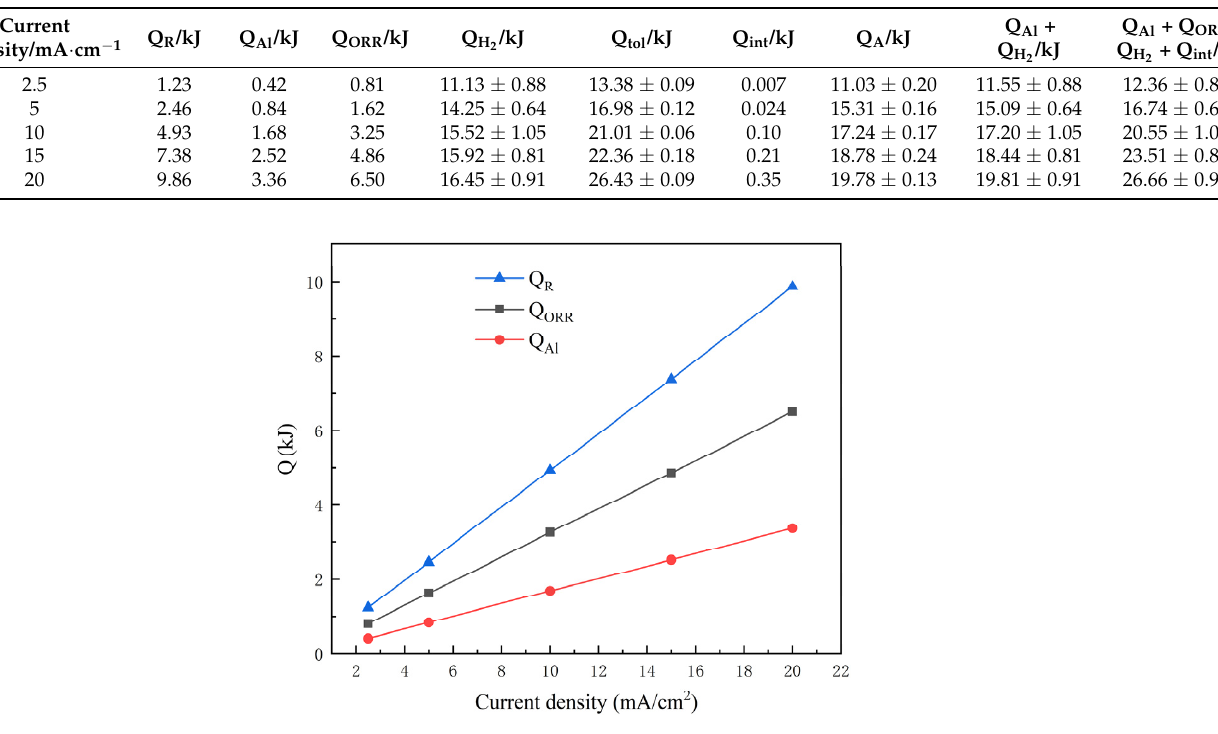
cy to 1400 mL/h with a current density of 20 mA/cm 2 . The increasing hydrogen- evolution rate slowed when the current density was greater than 10 mA/cm 2 . This ob- servation is mainly attributed to the increase in hydrogen-evolution potential induced by aluminum electrode polarization and the resulting inhibition effect on the hydrogen- evolution reaction [25]. In accordance with Equations (28) and (31), the values for Q H 2 al- so exhibited a similar trend, as shown in Figure 6b. Figure 6. ( a ) Hydrogen-evolution rate and ( b ) Q H 2 with different discharge current densities. The heat generated by the aluminum anode reaction is given as Q A , which consists of Q Al and Q H 2 and related to the heat from the discharge reaction of the aluminum elec-